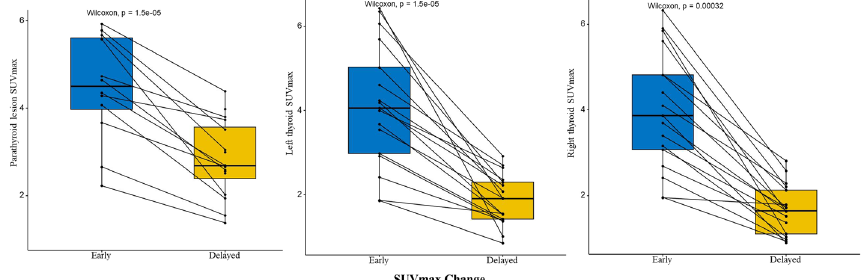
Fig. 2 SUVmax changes in early and delayed phase in parathyroid lesions and both thyroid lobes. Boxplots indicate median value (black line), first and third quartile ranges (box). The SUVmax of both parathyroid lesions (left) and thyroid dual lobes (middle, thyroid left lobe; right, thyroid right lobe) in early phase was higher than in delayed phase with significant differences. Rank-sum testing for paired samples used for the difference between two phases in parathyroid lesions and thyroid dual lobes. All the differences were statistically significant ( P <